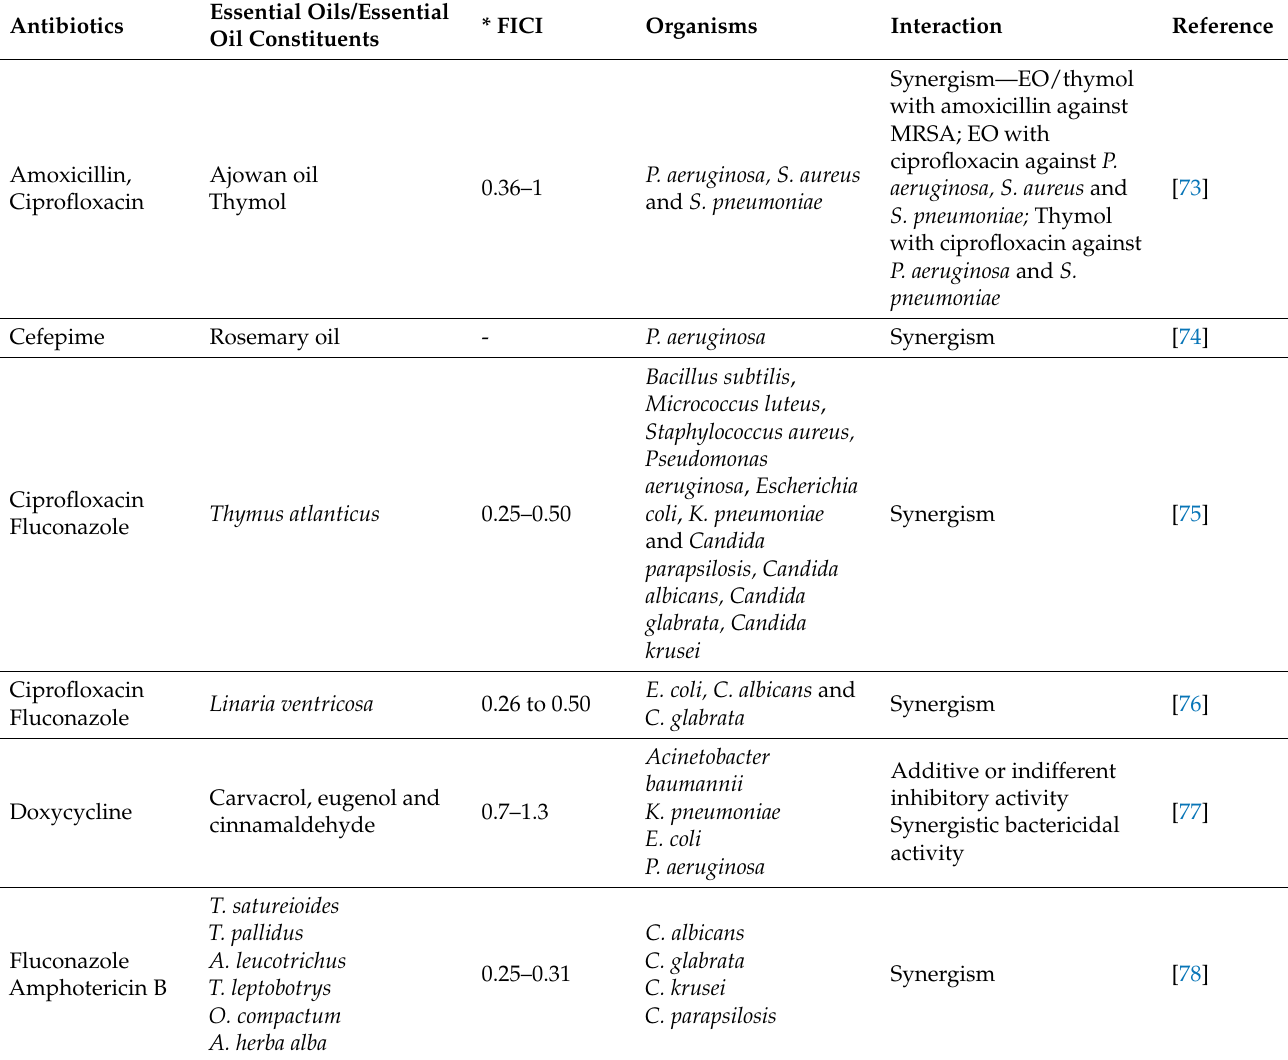
Table 2. Antibiotics in combination with Essential oils and their